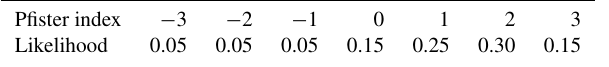
Table 3. Example of the distribution of likelihoods of a summer with no description of weather during a phase with otherwise good source density. Pfister index